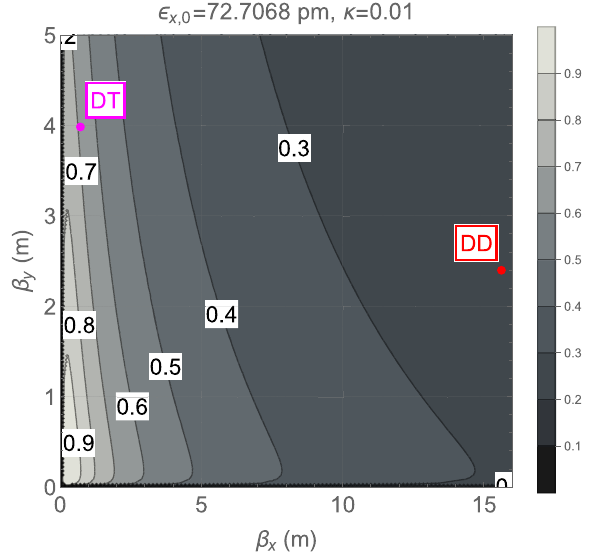
FIG. 23. Normalized brightness versus horizontal and vertical beta functions. Lighter color means higher brightness.